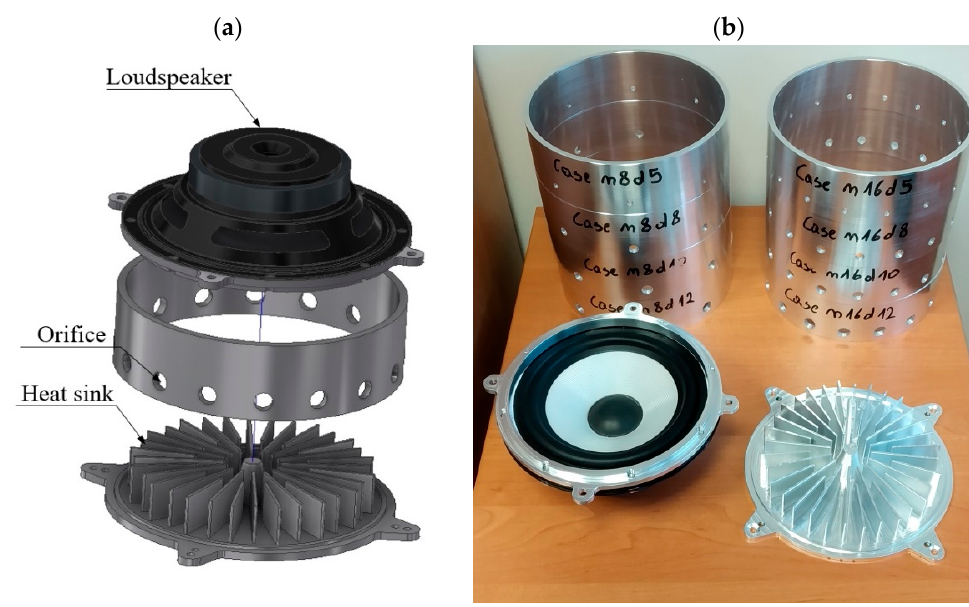
Figure 1. Model ( a ) and photo ( b ) of the SJA.